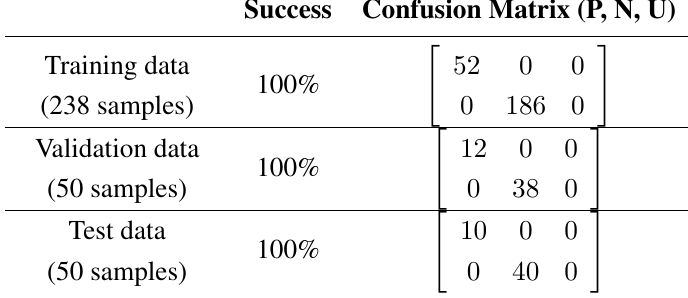
Table 2. Evaluation of the classifier for alcohol strip lateral histograms. Note that confusion matrices have dimensions of 2 × 3, because “undetermined” samples were never considered as an input.